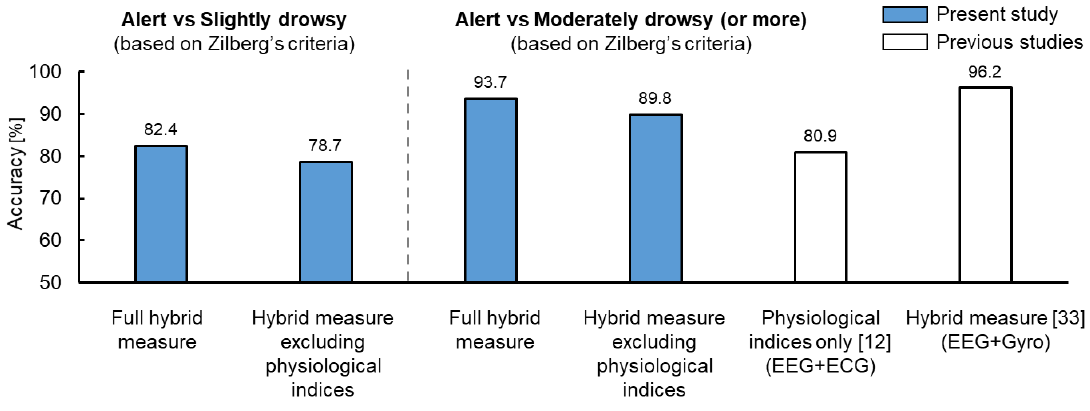
Figure 7. Classification accuracy of driver drowsiness in present study (with RF algorithm) and previous studies [12,33].